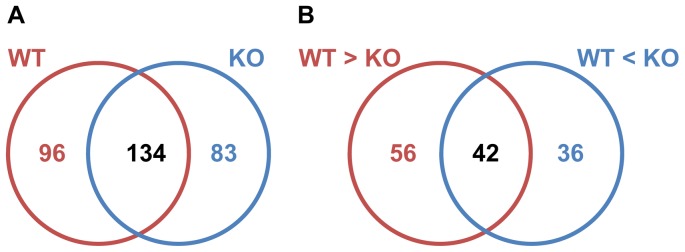
Proteomic analysis of WT and KO exosomes.A Venn diagram of proteins shared between WT and KO exosomes as well as unique proteins. B Venn diagram of common proteins between WT and KO exosomes, showing number of proteins with higher abundance (2×).